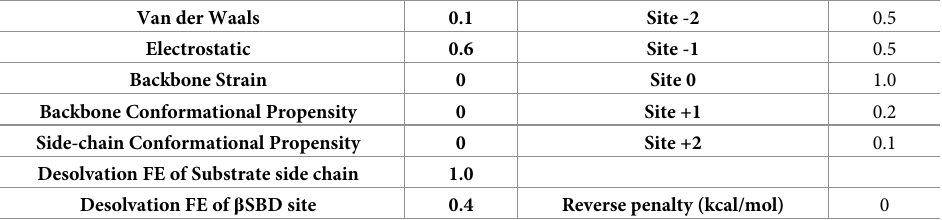
Table 1. Term and site weights and reverse orientation penalty of the Paladin model.